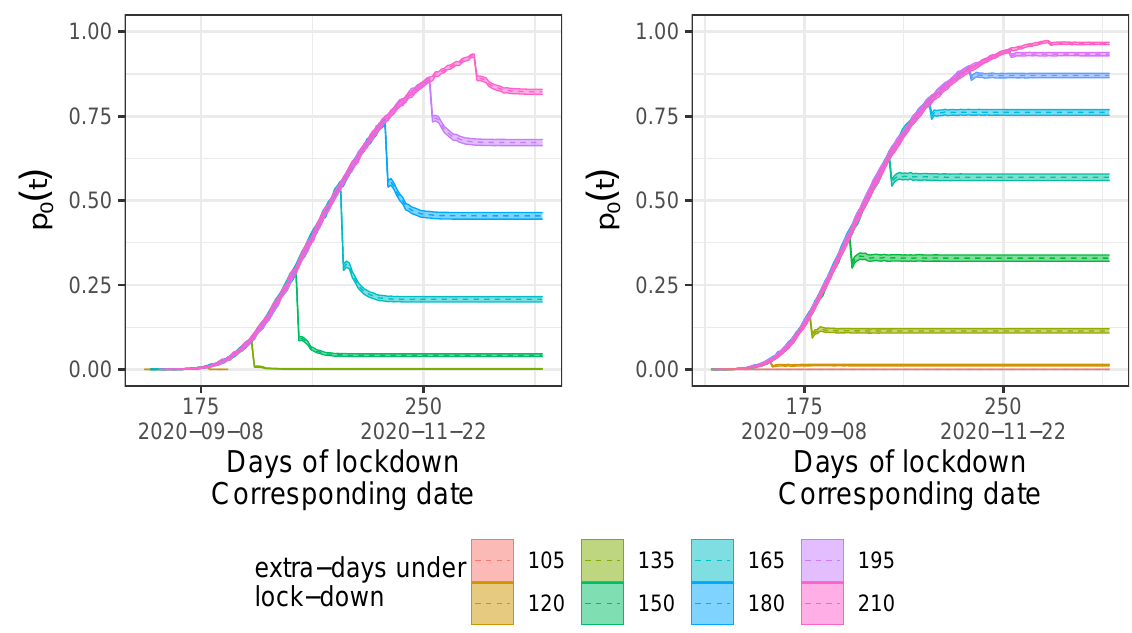
Figure S7 – Variation of the estimated probability of having no new cases p p 0 p t qq with finite lock-down extension post 11 May : Here the x-axis corresponds to the number of days since the start of the lock-down (Mar 17) and to the corresponding date and the y-axis to estimation of the estimated probability of having no new cases. For the first 55 0.24 ), after this period days we set the contact rate to its estimated value in France ( η t “ we increase this rate to η t 55 “ 0.267 for a fixed duration ( d ) comprised between 15 ą days to 210 days. For the rest of the simulation we release all contact rate restrictions ( η t 55 d “ 1 ). On the left panel we displayed the case without superspreading events ą ` and on the right panel when accounting for transmission heterogeneity. We plotted the estimation of the probability of epidemic extinction as dashed lines and the confidence interval as solid